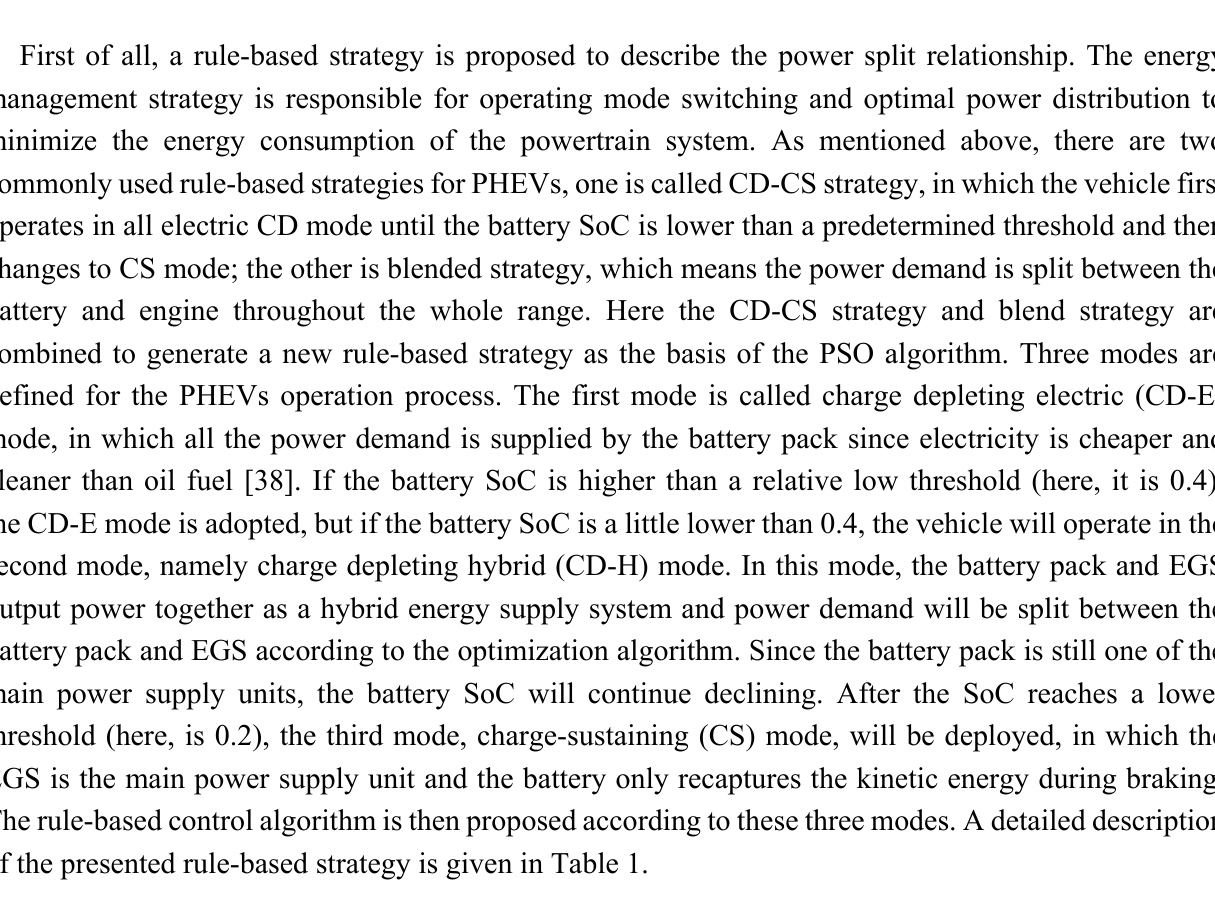
Table 1. The rule-based control